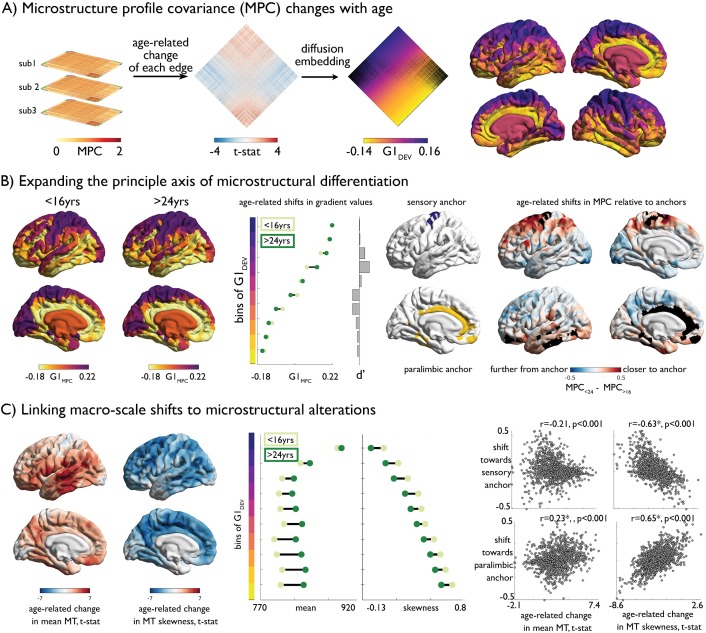
Age-related changes in microstructure profile covariance (MPC).(A) Subject-specific MPC matrices (stacked) were used in mixed effect models to calculate age-related changes in microstructural similarity between each node pair, generating a t-statistic matrix (middle). Diffusion map embedding ordered this matrix along the principal axis (G1DEV) (right). Rows of the matrix were coloured according to G1DEV. Surface projection of G1DEV illustrates a transition from primary sensory (purple) through association (pink) to limbic cortices (yellow). (B) Left. Principal axis of microstructural differentiation within extreme age strata (G1MPC), show a sensory-fugal axis similar to the baseline and developmental analysis. Middle. Shifts in average G1MPC within ten discrete bins of G1DEV, and corresponding Cohen’s d effect size. Central regions of G1DEV, aligning with association cortices, expand from the centre of G1MPC, towards either sensory or paralimbic anchors. Right. Age-related shifts towards anchors visualised via age-strata difference in MPC. The average MPC to each anchor was calculated within each extreme age-strata then subtracted. Prefrontal and parietal areas increased in microstructural similarity with the sensory anchor (top), whereas temporal regions became more coupled with the paralimbic anchor. (C) Left. Age-related change in MT moments (unthresholded maps from Figure 2B). Middle. Age-related shifts in mean and skewness within each bin of the gradient. Right. Correlation betweeBn age-related change in MT moments (Figure 2B) and shifts to anchors (B right).